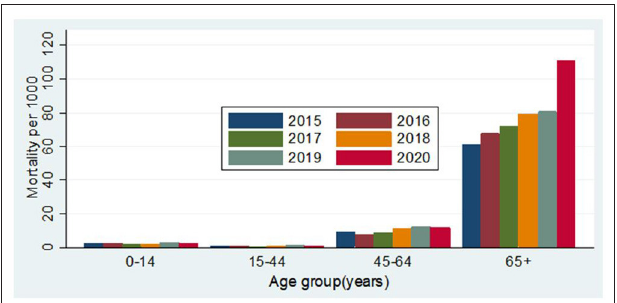
FIGURE 3 | Mortality per 1,000 person-years according to age and year.